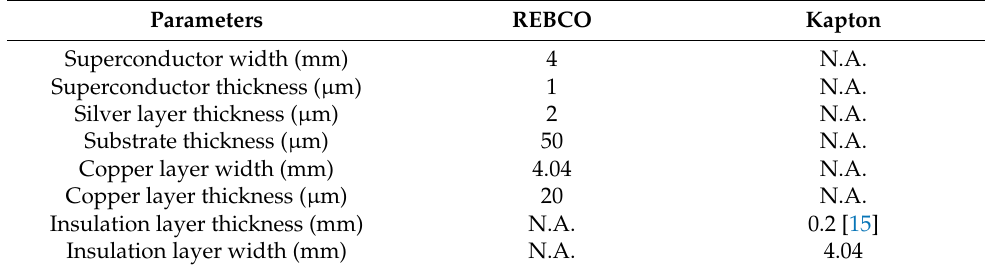
Table 1. Parameters of the REBCO and Kapton